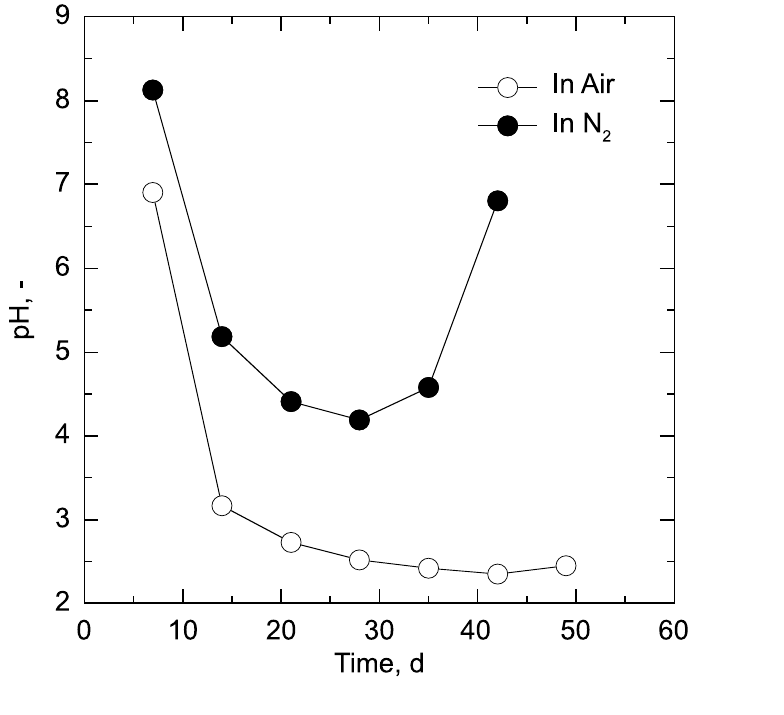
Fig 4. pH values of the condensate